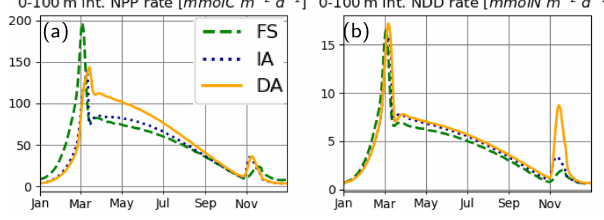
Figure 10. (a) Water-column-integrated NPP rate [mmolCm − 2 d − 1 ] and (b) water-column-integrated NDD rate [mmolNm − 2 d − 1 ], as simulated by the IA (fine-dashed dark blue line), DA (continuous orange line) and the FS (dashed green line)